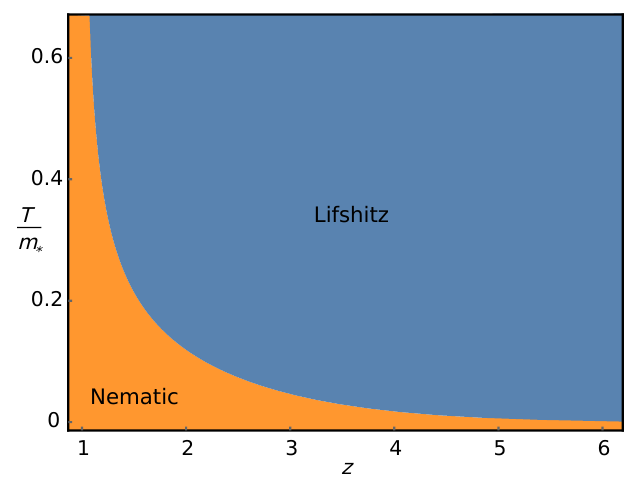
Figure 6 . Phase diagram in the temperature versus dynamical critical exponent plane. We see that the critical temperature for the nematic phase decreases as the value of the critical exponent increases. The horizontal axis corresponds to z = z ( q ) , defined as a solution to eq.